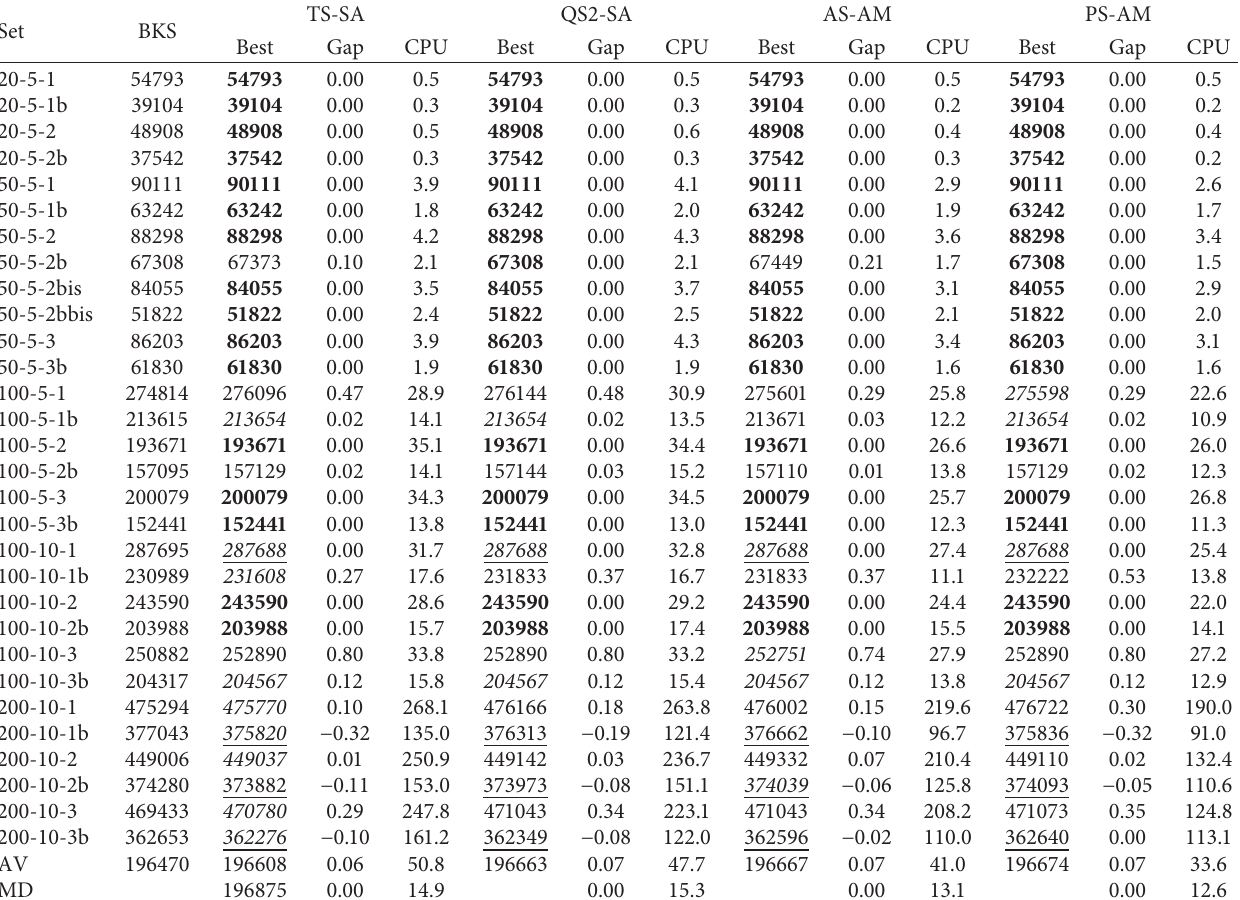
Table 5: Results for the CLRP instances in Prins